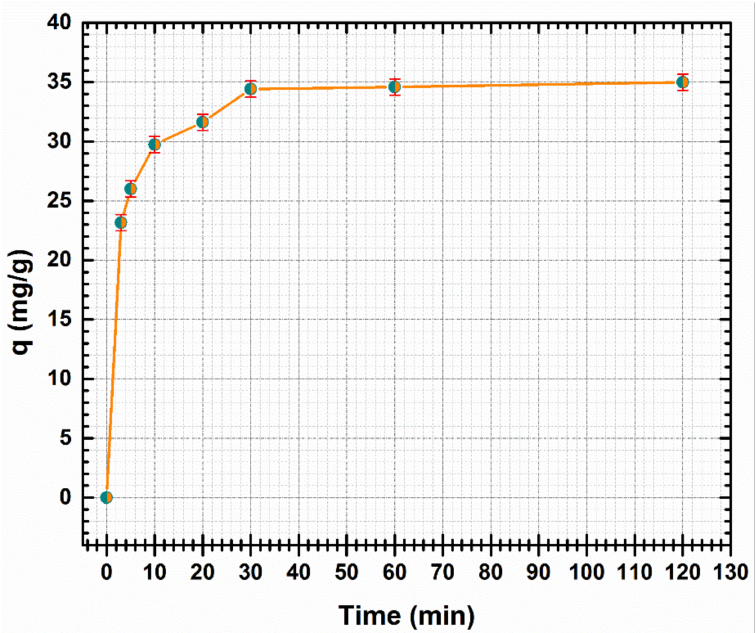
Figure 7. Effect of contact time on the adsorption of Cd (II) by CF@CMC.